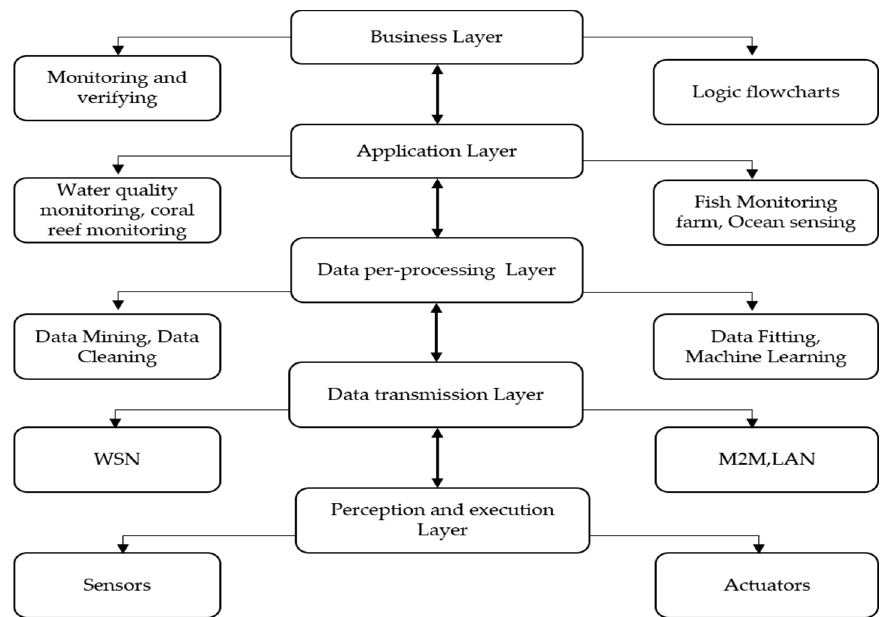
Figure 1. IoT application domains.